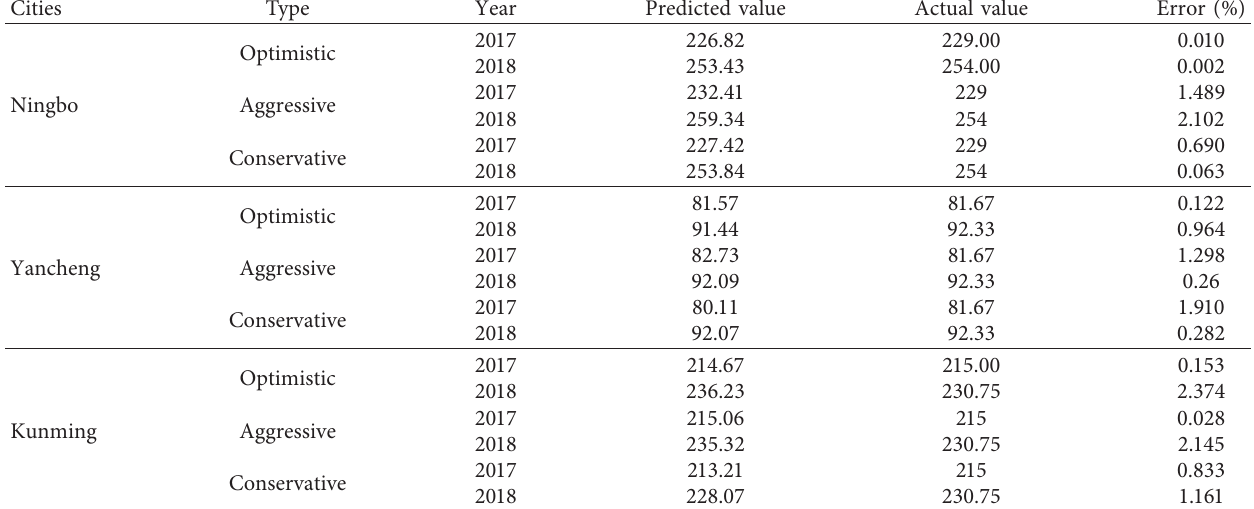
Table 11: Comparison of the predicted and actual CO values (unit (10 thousand)).